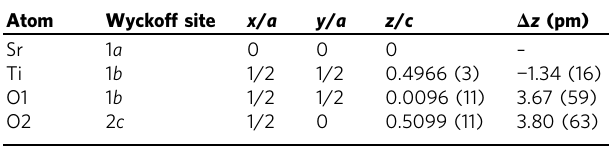
The result refers to a selected strain of Δ c c ¼ 0 : 15 % ( c = 3.911 and a = 3.904 according to the Poisson ’ s ratio). The origin was de fi ned at the Sr position. Given errors correspond to 1 σ uncertainty. The re fi nement includes measurements of spectra for six re fl ections (see Fig. 4)